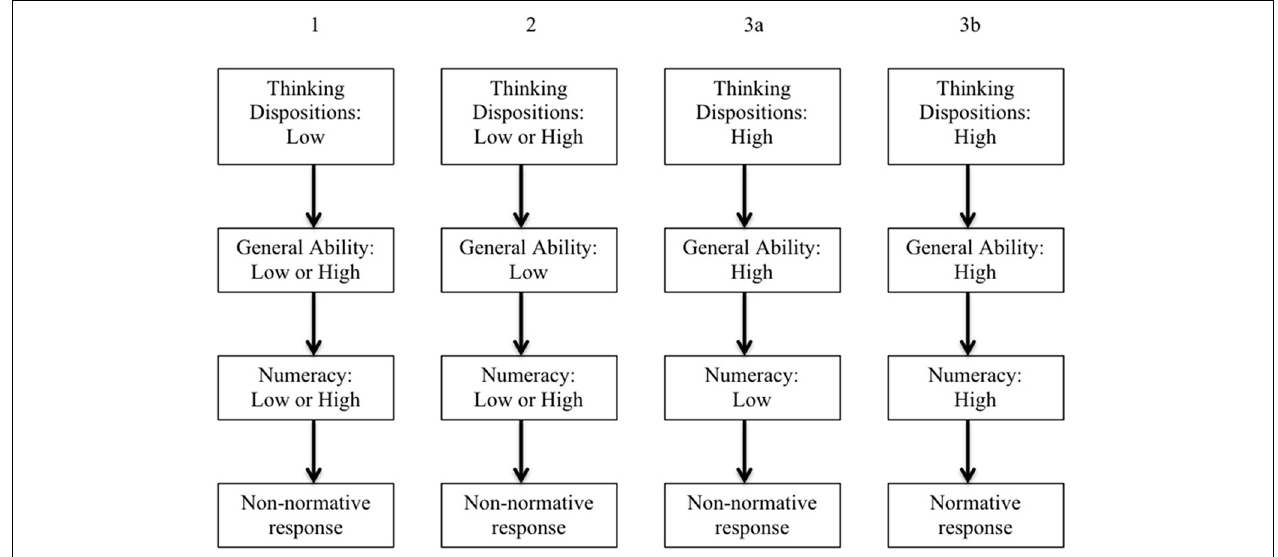
FIGURE 1 | Predicted relationships among thinking dispositions, general ability, numeracy, and normative responses on probabilistic HB